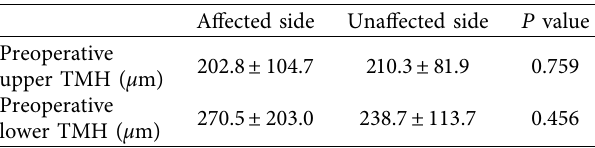
Table 4: Comparison of preoperative tear meniscus height (TMH) between the afected and unafected sides in patients with unilateral involutional